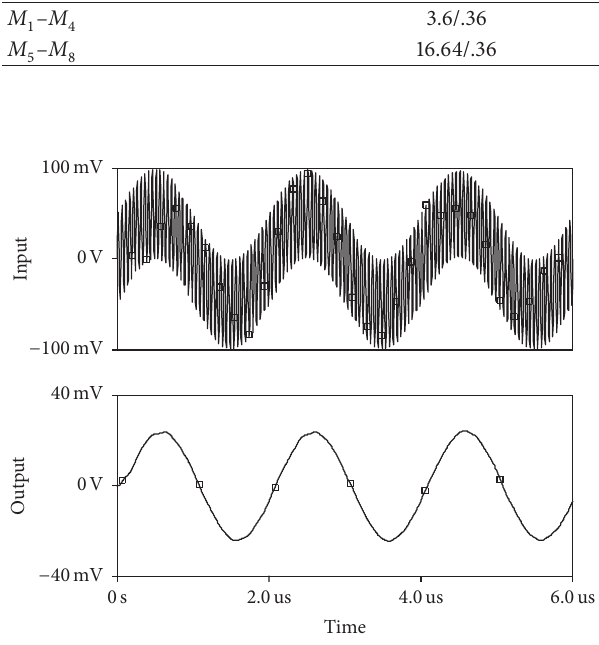
Figure 10: Transient response of input and output signals.